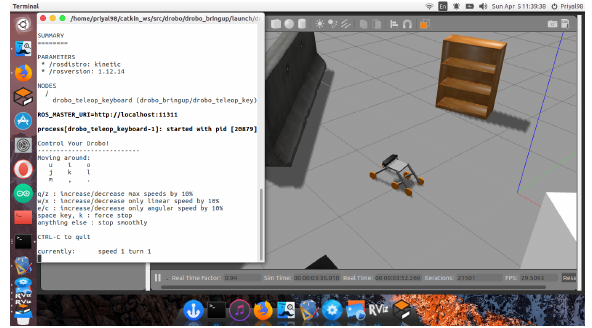
Figure 9. Drobo Model Simulation